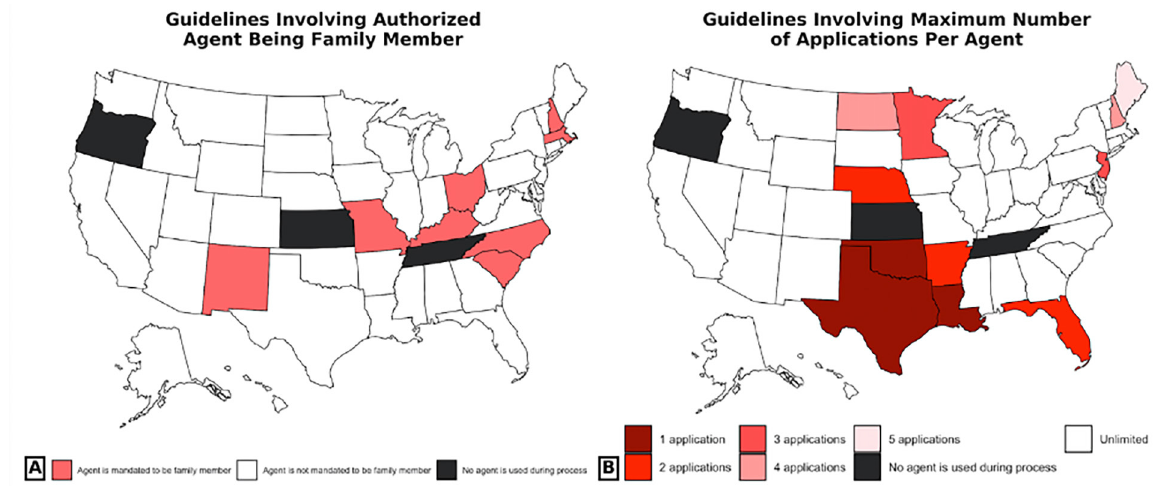
Figure 2. Statewide rules for voter’s authorized